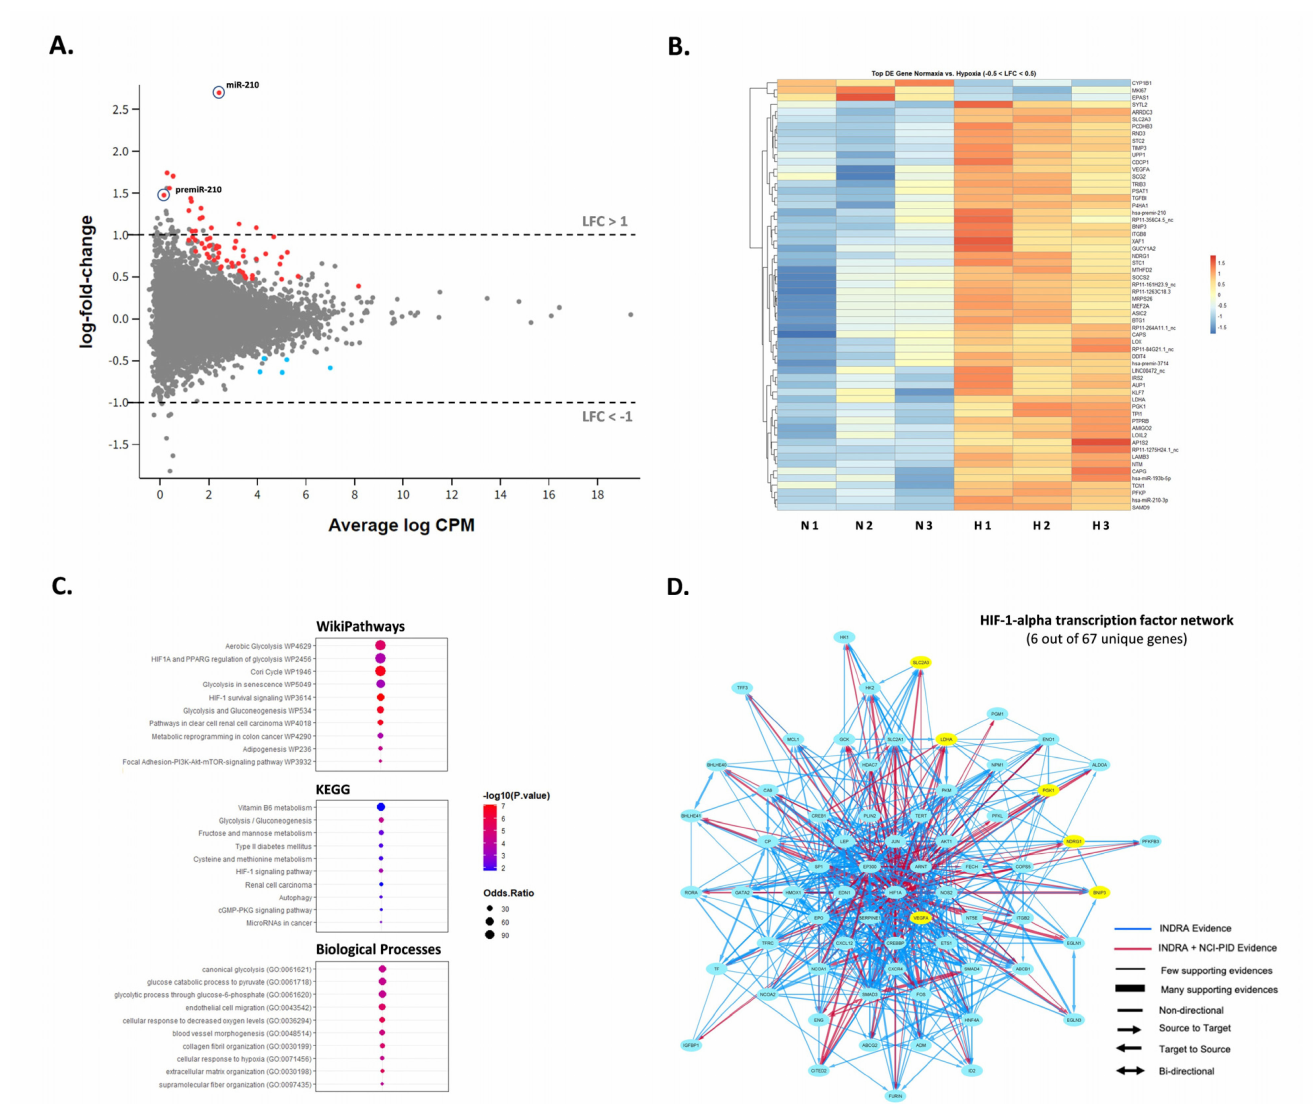
Figure 3. SW1736 cellular miRNA expression in hypoxia at 72 h. ( A ). The MD plot showing differential expression of miR-210-3p, pre-miR-210 as well as mRNA and lncRNA transcripts in hypoxia vs. normoxia datasets. Significantly deregulated genes (adj. p -value < 0.05) are shown in color. ( B ). Heatmap of the normalized read counts for all differentially expressed transcripts with − 0.5 < LFC < 0.5 and adj. p -value < 0.05 ( n = 66 in total). ( C ). Gene ontology, KEGG and pathway analysis of the deregulated genes in normal vs. hypoxic cells. ( D ). The NCI-Nature Pathway Interaction Database (PID) image visualizing HIF-1-alpha transcription network with the indicated protein-coding genes differentially expressed in datasets from hypoxic cells (in